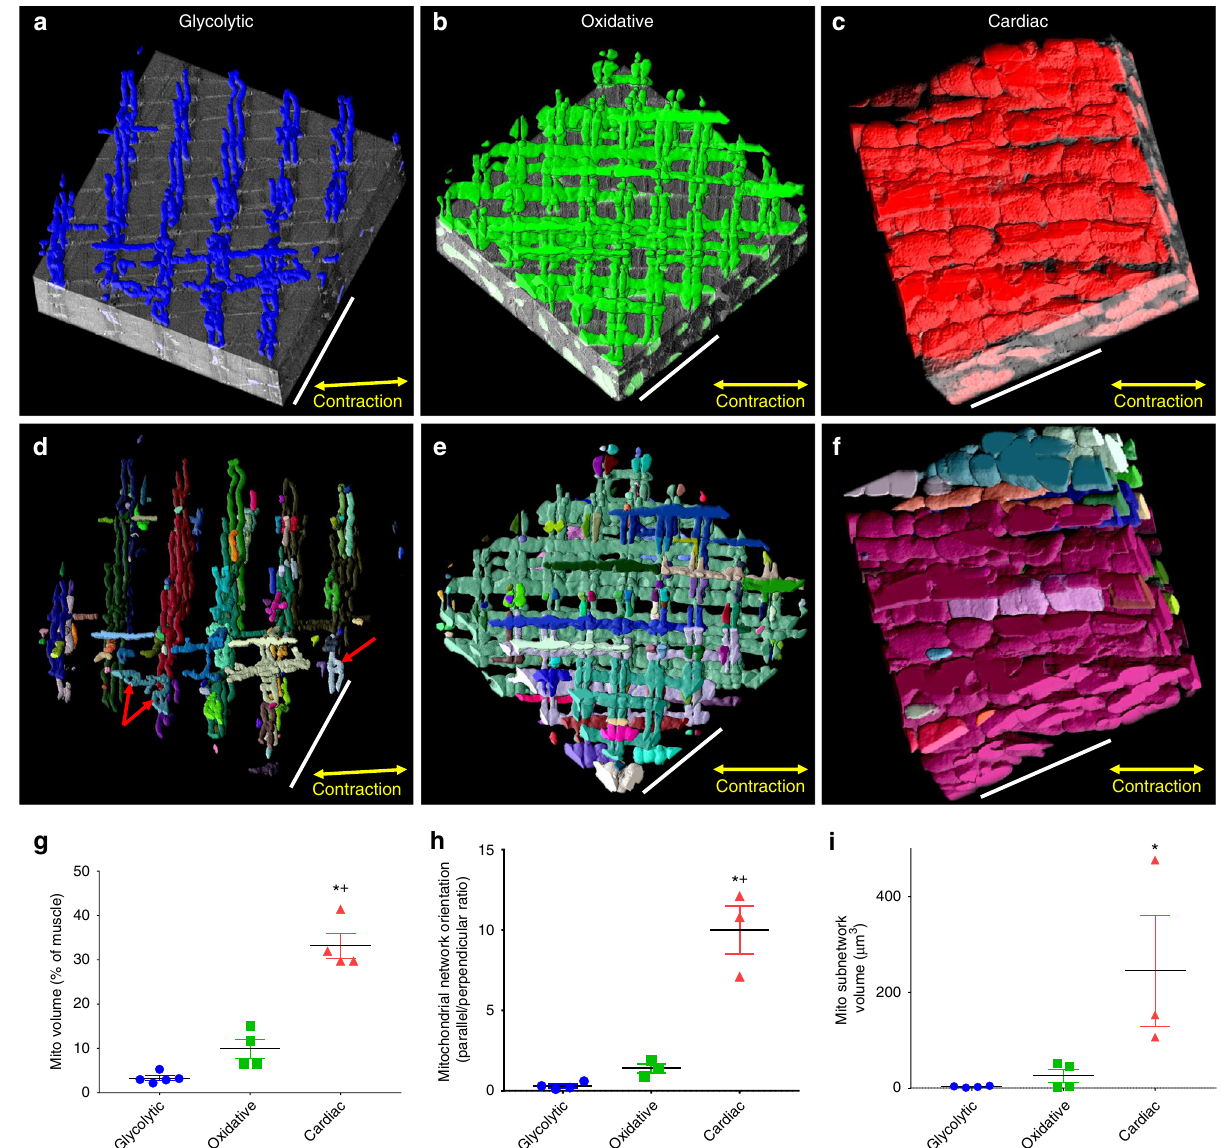
Fig. 1 Mitochondrial network connectivity depends on muscle fi ber type. a 3D rendering of perpendicularly oriented glycolytic muscle mitochondrial network partially overlaid on raw serial block face scanning electron microscopy (SBF-SEM) data. b Grid-like oxidative muscle mitochondrial network partially overlaid on raw focused ion beam scanning electron microscopy (FIB-SEM) data. c Parallel cardiac muscle mitochondrial network partially overlaid on raw FIB-SEM data. d 3D rendering of connected subnetworks within the glycolytic muscle mitochondrial network. Each color represents a connected mitochondrial subnetwork. e Connected subnetworks within the oxidative muscle mitochondrial network. f Connected subnetworks within the cardiac muscle mitochondrial network. g Mitochondrial volume as a percent of total muscle volume. glycolytic, n = 5; oxidative, n = 4; cardiac, n = 4 datasets. h Quanti fi cation of mitochondrial network orientation. Dotted line represents parallel equal to perpendicular. glycolytic, n = 4; oxidative, n = 3; cardiac, n = 3. i Mitochondrial subnetwork volumes. glycolytic, n = 674 subnetworks, 4 datasets; oxidative, n = 1558 subnetworks, 4 datasets; cardiac, n =